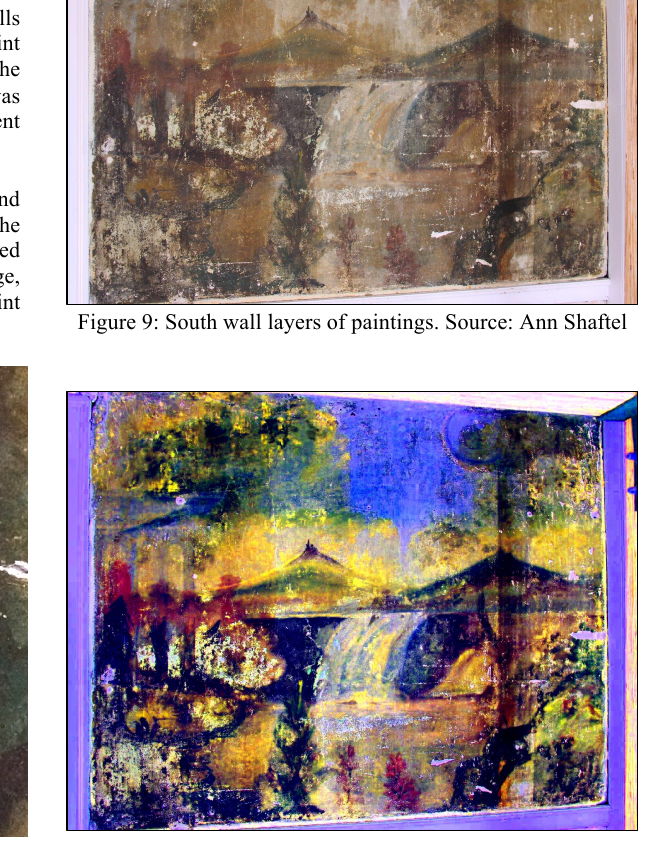
Fig 8: Documentation of condition. Source: Ann Shaftel